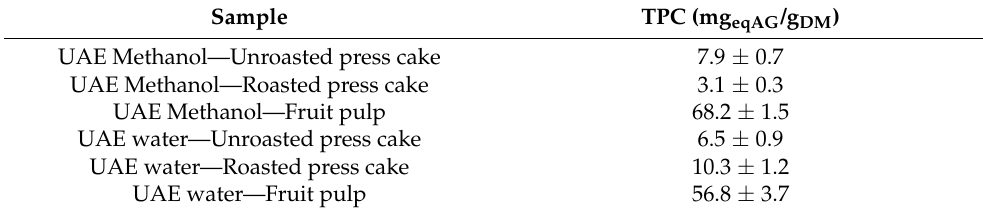
Table 2. Content of total phenolic compounds (TPC) (mean values ± standard deviation) expressed in mg gallic acid equivalent per gram of dry matter (mg eqAG /g DM ) in argan press cake and fruit